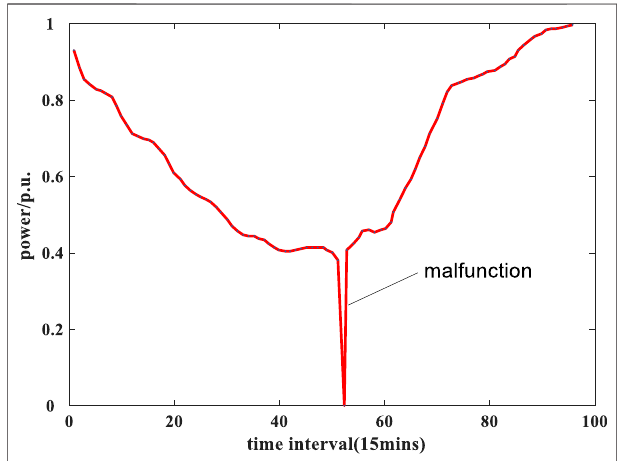
FIGURE 5 | Node voltage levels (p.u.) simulated without or with the PV access at peak time ( t (cid:1)